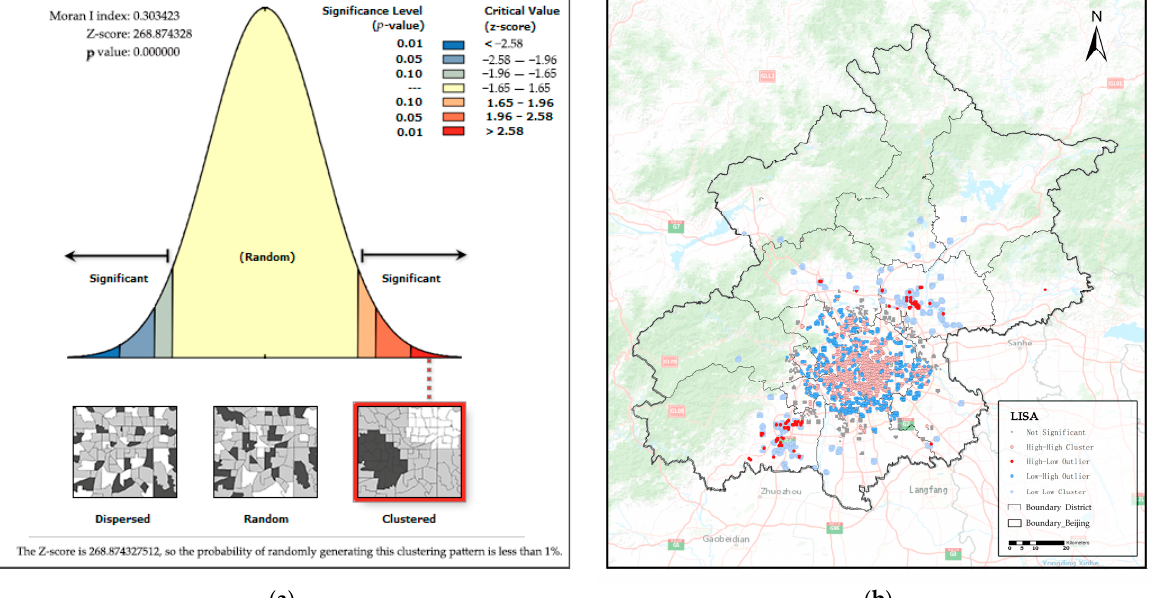
Figure 5. Results of spatial autocorrelation analysis: ( a ) Results of Moran’s 1 spatial autocorrelation analysis; ( b ) LISA analysis results.